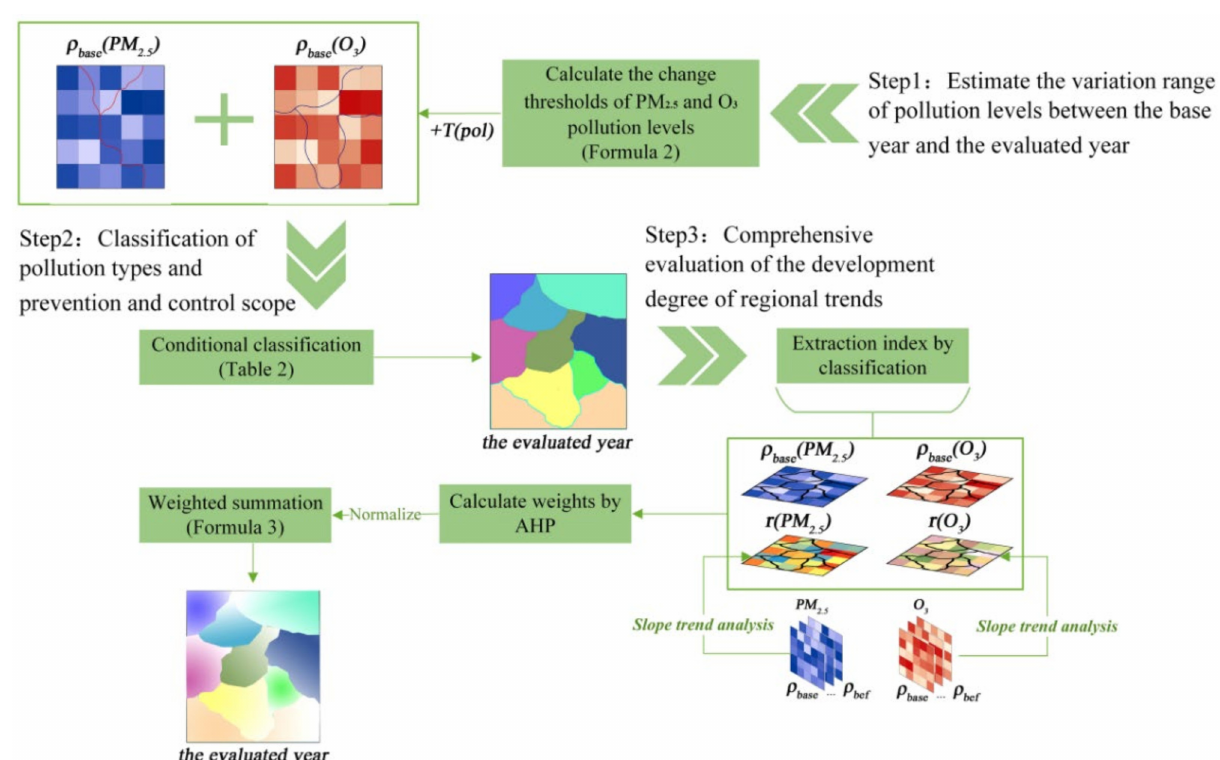
Figure 2. Process of dividing the scope of combined pollution and evaluating regional trends.